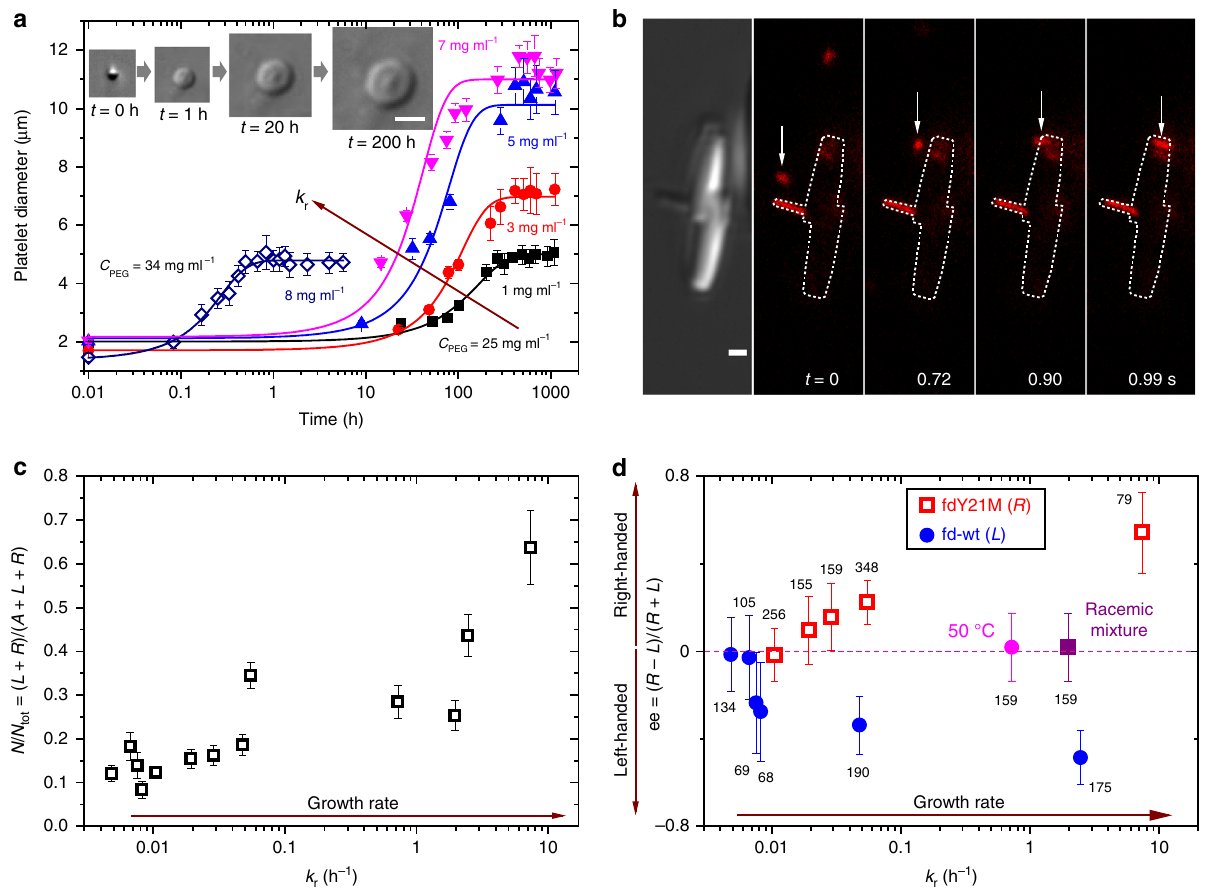
Fig. 3 Platelet screw dislocation handedness monitored by the kinetics of growth. a Radial growth of the hexagonal platelets characterized by the growth rate k r de fi ned according to Eq. (1). k r increases both with the initial viral rod (fdY21M strain) concentration and with the depleting polymer concentration (varied from 25 to 34 mg ml − 1 ). The kinetics of growth is obtained from DIC image sequences as shown in insets (Supplementary Movies 6 and 7). Error bars: standard deviation. Scale bar, 2 μ m. b Observation at the single particle level of the 2D growth of a helical platelet seen by DIC microscopy. A fl uorescently labeled rod (tracked by a white arrow) is shown to diffuse in the liquid phase before attaching at the platelet edge (Supplementary Movie 8). For clarity, the outline of the platelet is indicated in the fl uorescence images (white dotted line). c The ratio of chiral and antichiral platelets, N = L + R , exhibiting screw dislocation, over the total number of platelets N tot (including the achiral ones, A ), increases with the kinetics of growth. d The enantiomeric excess, ee, associated with the platelet screw dislocation handedness is driven both by the growth rate and by the intrinsic helical twist of the constituent chiral particles i.e., left-handed and right-handed for fd-wt and fdY21M, respectively. Each error bar corresponds to a con fi dence level of 95%, and the number of measured dislocations N is indicated for each data point. The racemic conditions are marked by a red dashed line, and have been obtained either by a mixture of viral rods with opposite chiralities 24 or by an fd-wt suspension at high temperature (50 °C) for which the chiral twist vanishes